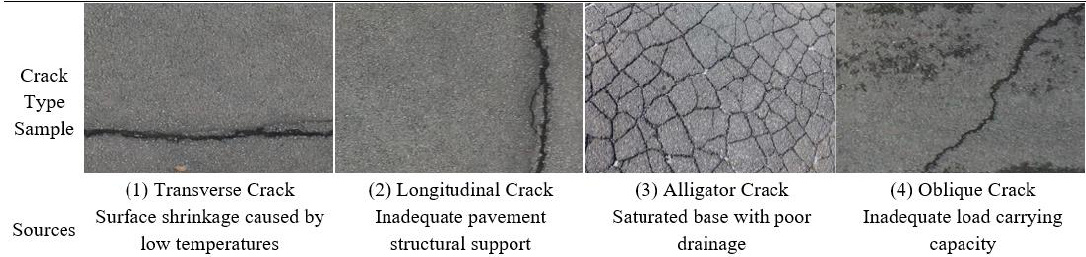
Figure 1. Some samples of common pavement